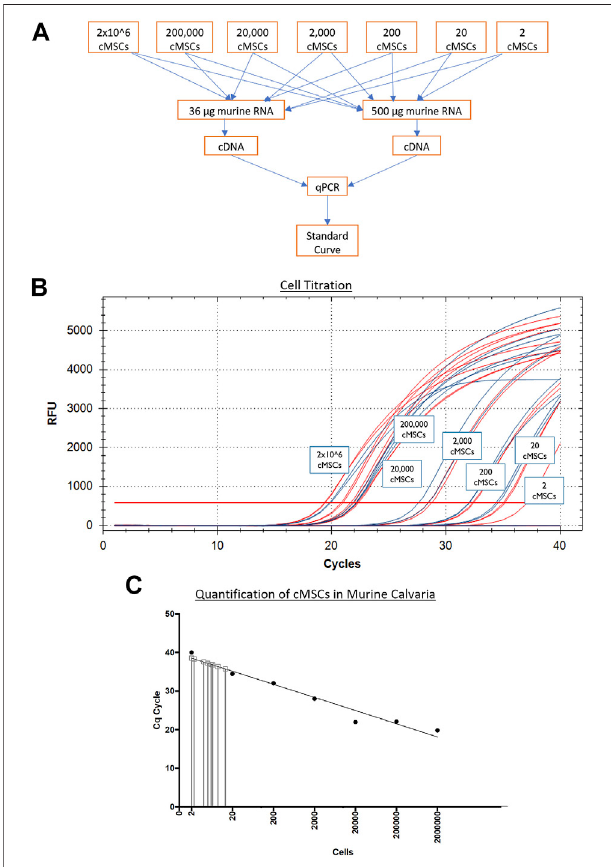
FIGURE 3 | Generation of a qPCR-based cMSC standard curve to detect cMSCs in calvarial defects at Day 10. (A) : Serial dilutions of RNA were performed on RNA extracted from 2 × 10 6 total cMSCs. RNA samples were added to individual sample tubes containing either 36 or 500 μ g of murine RNA to determine if the amount of murine RNA would affect the ability to identify canine RPL13A. cDNA samples were generated and qPCR was performed. (B) :qPCRampli fi cationcurvesareshownforcanineRPL13Afrom cDNA samples generated with either 36 μ g (red lines) or 500 μ g (blue lines) of murine RNA. (C) : Cycle thresholds from Panel A (red lines) were used to generate a standard curve using a linear curve fi t technique. RNA samples wereisolatedfromthecalvarialdefectstreatedwithcMSCsorcMSCs+BMP- 2. These samples contained both murine and canine RNA. cDNA samples were generated and qPCR performed for canine RPL13A. Cycle threshold results were interpolated on the standard curve. At Day 10 post implantation, only 2 – 20 total cMSCs were